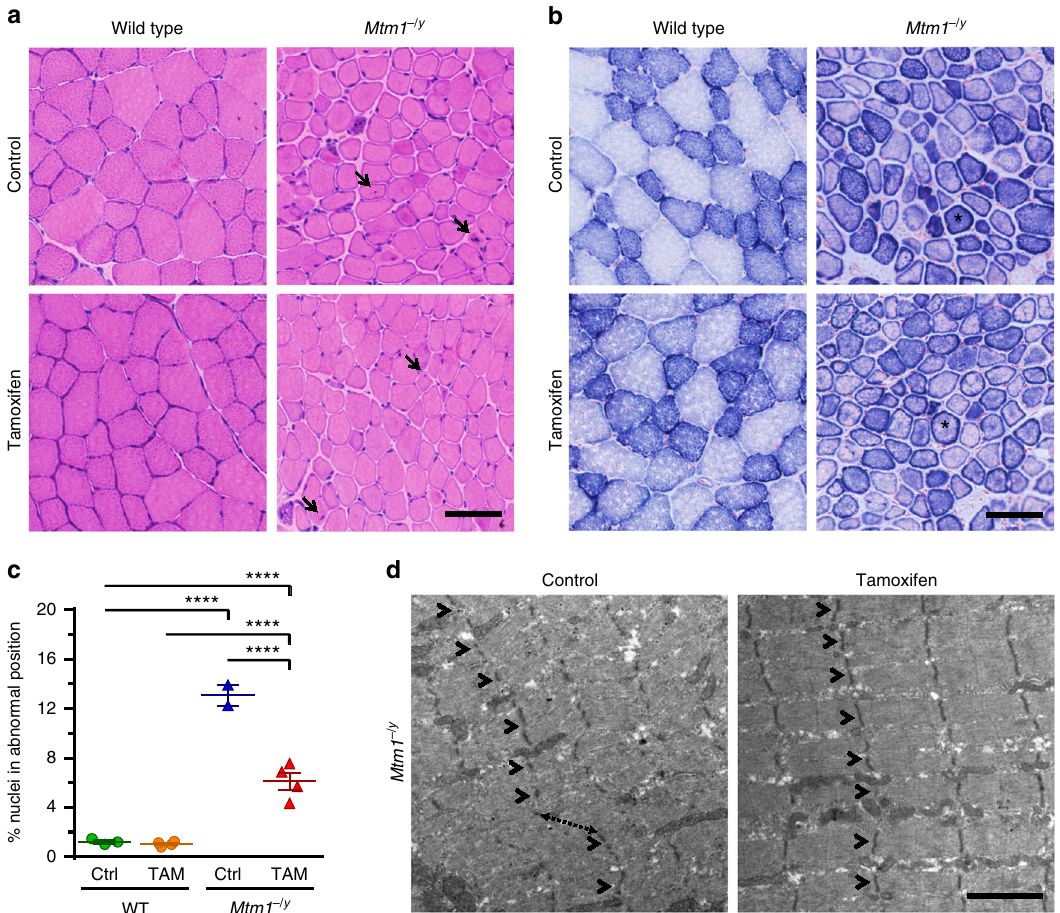
Fig. 3 Tamoxifen mitigates muscle structure and improves sarcomeric organization in XLMTM mice. Muscle structure and sarcomere ultrastructure were examined by histology and transmission electron microscopy, respectively, in 42-day-old (D42) mice either untreated (control; Ctrl) or treated with tamoxifen (TAM; 30 mg kg − 1 of diet). a Representative pictures of hematoxylin – eosin stained sections from the tibialis anterior (TA) of D42 mice. Note the small size of the Mtm1 − /y myo fi bres and the presence of mislocalized nuclei, a hallmark of Mtm1 − /y mice and XLMTM patients (arrows). b Representative pictures of succinate dehydrogenase (SDH) activity in TA sections of D42 mice, demonstrating abnormal distribution of oxidative staining. The intense staining forming a ring at the periphery of many Mtm1 − /y myo fi bres (examples shown by asterisks) is due to accumulated mitochondria and other organelles and is a hallmark of the pathology. c The percentage of nuclei abnormally positioned (either internally or centrally located) in TA myo fi bres of D42 mice were counted from hematoxylin – eosin-stained sections. That feature was reduced by 53.3% with TAM. Data represent the mean ± s.e.m. of n = 2 – 4 TA per group. **** P ≤ 0.0001. One-way ANOVA followed by Fisher ’ s LSD post-test. d Sarcomere ultrastructure revealed by transmission electron microscopy in the TA from untreated (control) and tamoxifen-treated Mtm1 − /y mice at D42. Note overall disorganization of the sarcomeres in untreated TA with disruption of the Z-lines (structures running perpendicular to the sarcomeres and holding myo fi brils together; arrowheads) and shifted sarcomeres (dashed arrow). Tamoxifen ameliorated the organization of the sarcomeres as demonstrated by in-register Z-lines in adjacent myo fi brils (arrowheads). The bar represents 50 µ m in a and b , and 2 µ m in